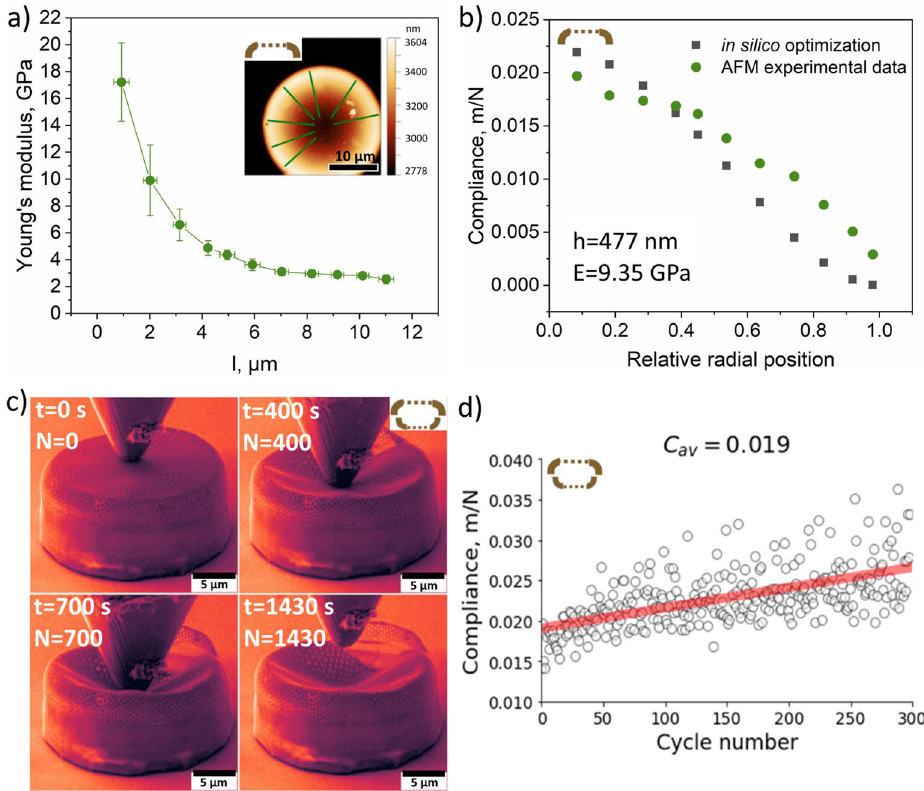
Figure 6. Compliance of cleaned frustules: static vs. dynamic approach. ( a ) Young’s modulus depending on the distance from the edge towards the center of the outer surface of the valve. Inset: topography of outer surface of a cleaned frustule. The measurements were carried out using AFM by pressing the diamond probe on the sample with a force of 7.7 µN along each green line. ( b ) Compliance vs. relative radial position calculated using the Green’s function of a point force, ( c ) SEM images of whole diatom frustule acquired during different stages of nanoindentation in the SEM column, ( d ) Calculated compliance vs. cycle number. Video material corresponding to Fig. 6c is provided in Supplementary Materials (see Supplementary Video